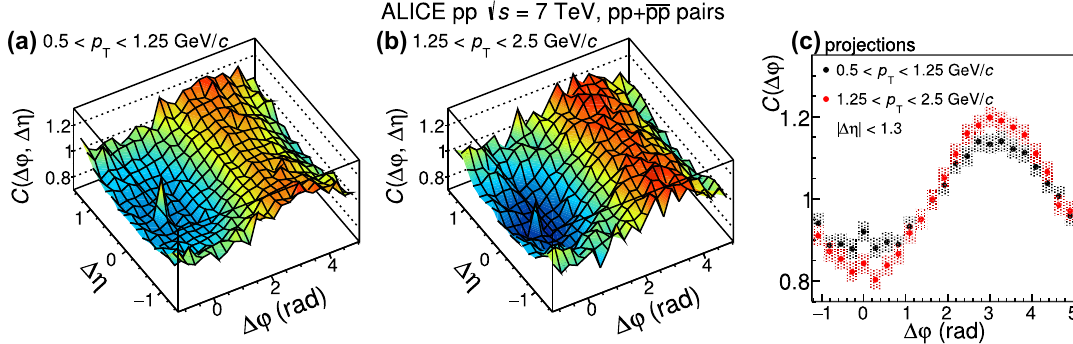
Fig. 4 Correlation functions for combined pairs of pp + pp for two transverse momentum intervals a 0 . 5 < p T < 1 . 25 GeV/ c and b 1 . 25 < p T < 2 . 5 GeV/ c . Panel c shows (cid:3)η integrated projections. Statistical ( bars ) and systematic ( boxes ) uncertainties are